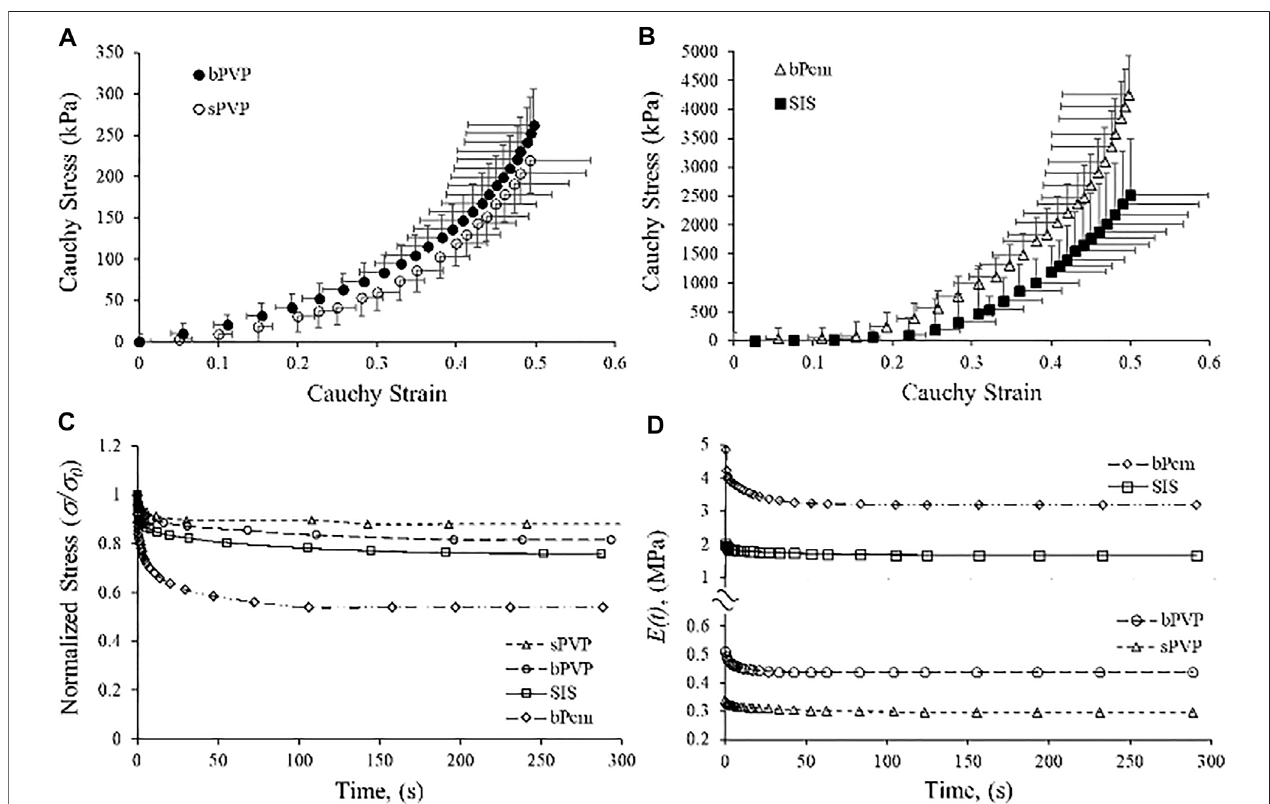
FIGURE 3 | Relationship of Cauchy stress-to-strain and stress relaxation of bPVP, sPVP, bPcm, and porcine SIS. (A) The relations of bPVP and sPVP. (B) The relations ofbPcm and SIS. (C) Typical curves for stress relaxation of sPVP, bPVP, SIS, and bPcm. (D) Time-dependent modulus E relax ( t ) for sPVP, bPV, SIS, and bPcm.